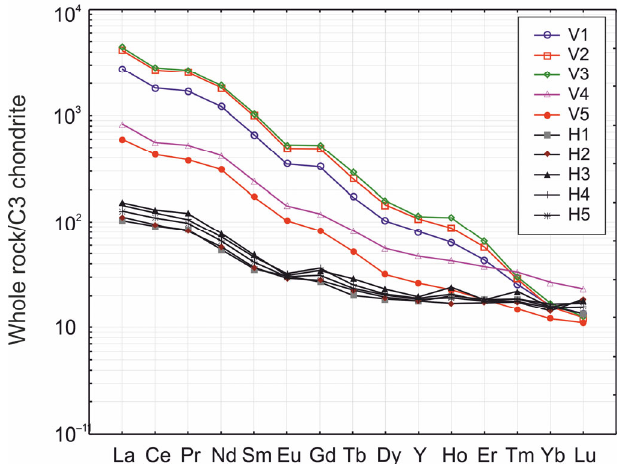
Figure 7. C3 chondrite–normalized REE distribution in the quartz–carbonate–sulfide vein with synchysite and the host rocks. (whole rock data were normalized following [35]). Explanation: veins V1–V3: quartz-dominated section of the vein; V4: quartz and carbonate filling; V5: carbonate-rich section of the vein; host rocks H1–H4: chloritized, argillized, and albitized gneisses; H5: slightly chloritized gneiss.